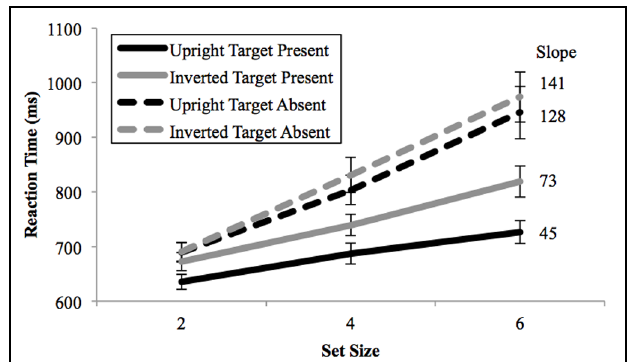
FIGURE 2 | Mean reaction times as a function of search array set size in Experiment 1. Upright Mooney faces were searched more efficiently than inverted Mooney faces. Black lines = upright conditions; Gray lines = inverted conditions; Solid lines, target-present; dash lines, target-absent. Search reaction time slopes for each condition are shown in ms/item to the right of the corresponding lines. Error bars represent ± 1 SEM